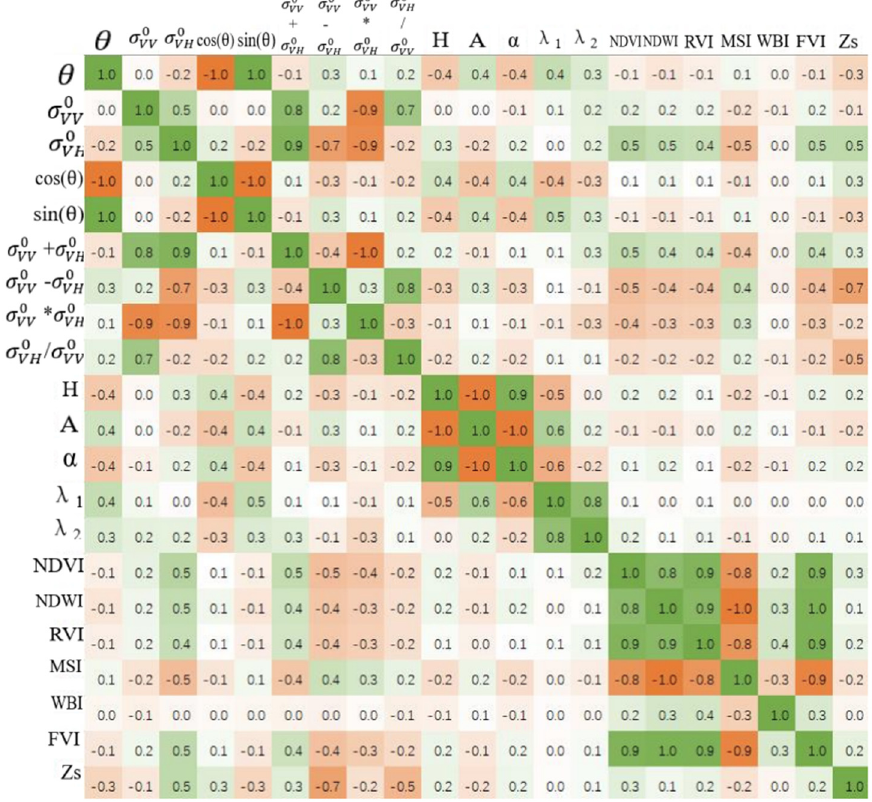
Figure 3. Correlation between features obtained by PCA method.